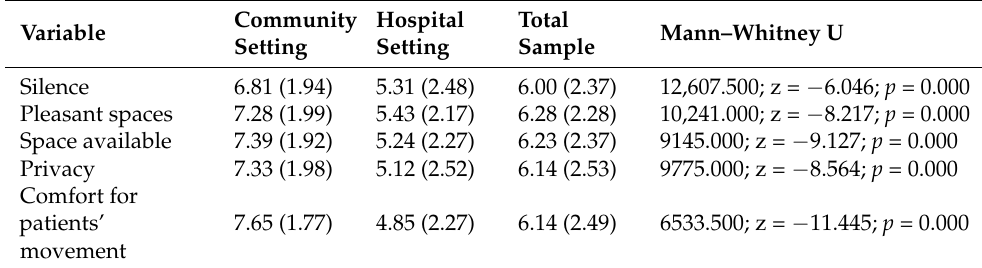
Table 2. Mean of the sample’s degree of agreement on comfort of